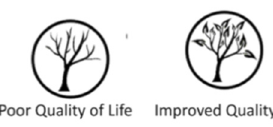
Figure 15. Improve Quality and Discourage Poor Quality of Life.